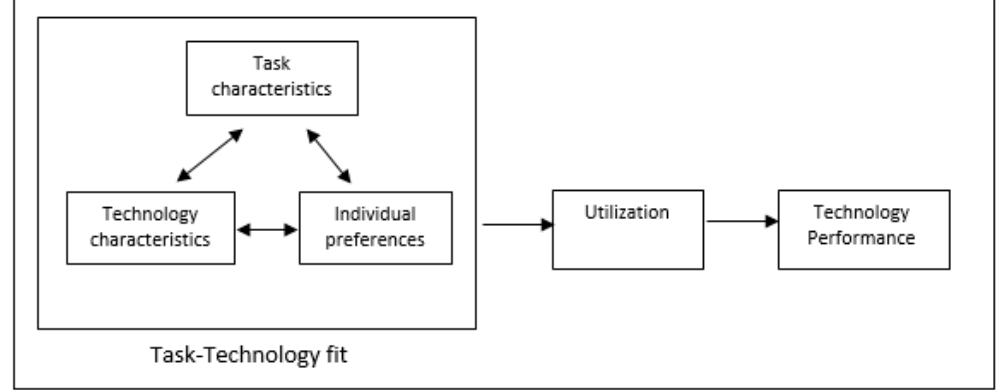
Figure 5. A representation of task-technology fitness theory. Based on Goodhue and Thompson.[17].